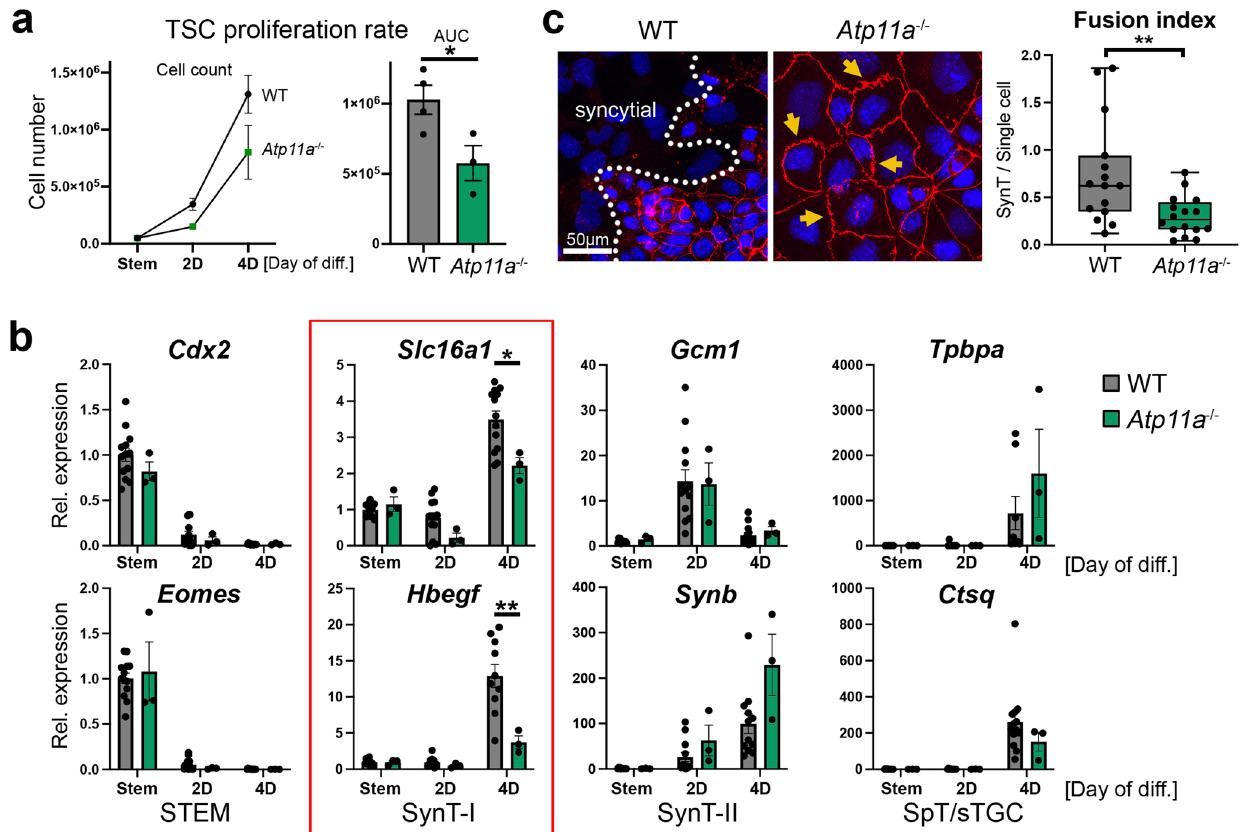
c Assessment of cell fusion capacity of WT and Atp11a − / − TSCs upon 4 days of differentiation. ZO-1 cell membrane staining (red) highlights membrane ruf fl ing (arrows) and fewer syncytialised areas in Atp11a − / − TSCs. Data are from WT: n =15 and Atp11a − / − : n =16imagesoftwoindependentclonespergenotypeamountingto >1600 counted nuclei each. The box plot shows the 25th to 75th percentiles with themedianindicated,andthewhiskersstretchfromtheminimumtothemaximum values, displaying all data points (Two-tailed Student ’ s t test, ** p <0.01). Source data are provided as a Source Data fi le. All exact p values are provided in Supple- mentary Data